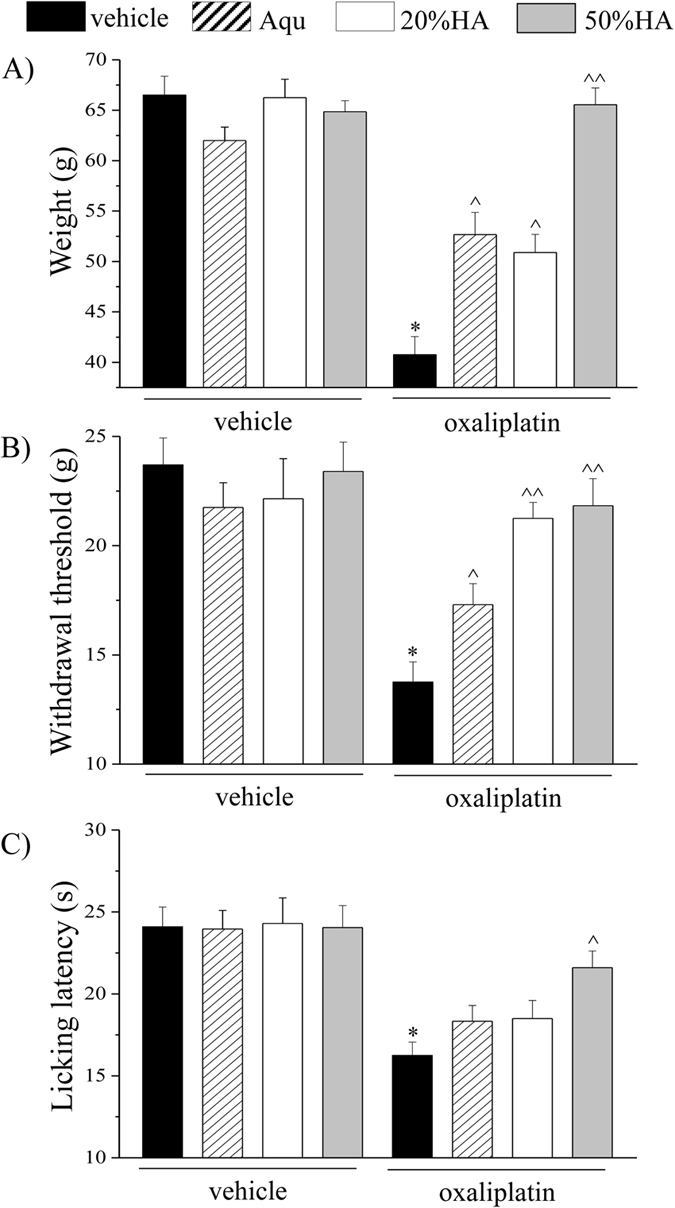
Behavioral measurements.(A) and (B) Pain: mechanical noxious and non-noxious stimuli. (A) Paw pressure test was used to measure sensitivity to a mechanical noxious stimulus. (B) The Von Frey test was used to measure the pain threshold as a response evoked by a non-noxious stimulus. (C) Pain: thermal non-noxious stimuli. The Cold plate test was used to evaluate the pain threshold measuring the latency to pain-related behavior (lifting or licking of the paw). Oxaliplatin (2.4 mg kg−1) was administered daily i.p. for 3 weeks. All Astragalus extracts (300 mg kg−1) were administered daily p.o. concomitantly with oxaliplatin. Behavioural evaluations were performed on day 21, 24 h after the last injection. Control animals were treated with vehicles. Each value represents the mean of 12 rats per group, performed in two different experimental sets. Values are represented as mean ± SEM. *P < 0.01 versus saline treatment; ^P < 0.05 and ^^P < 0.01 versus oxaliplatin treatment.